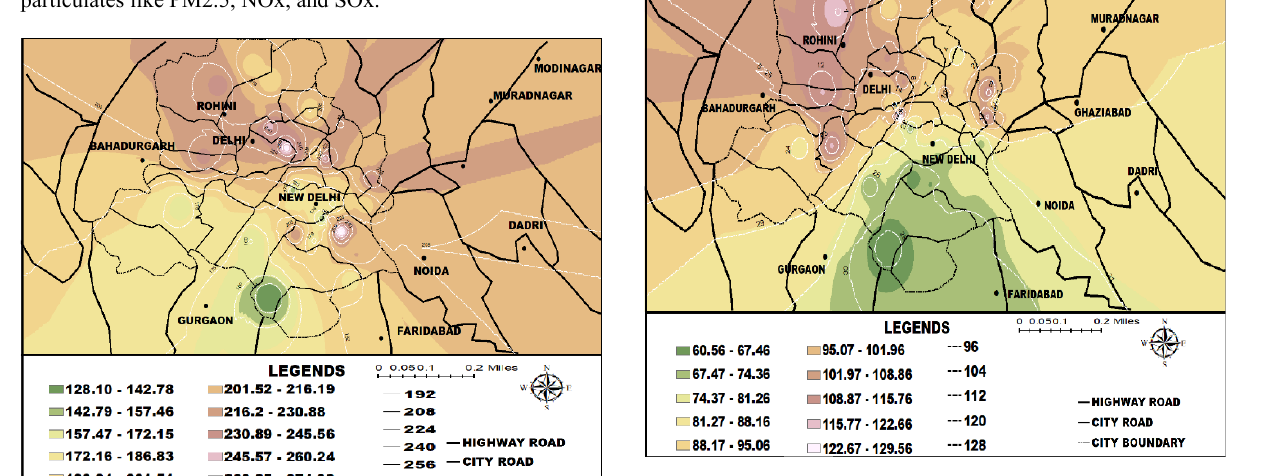
Figure 4. Air quality map of Delhi May monthly average based on PM2.5 (µg/m 3 ).